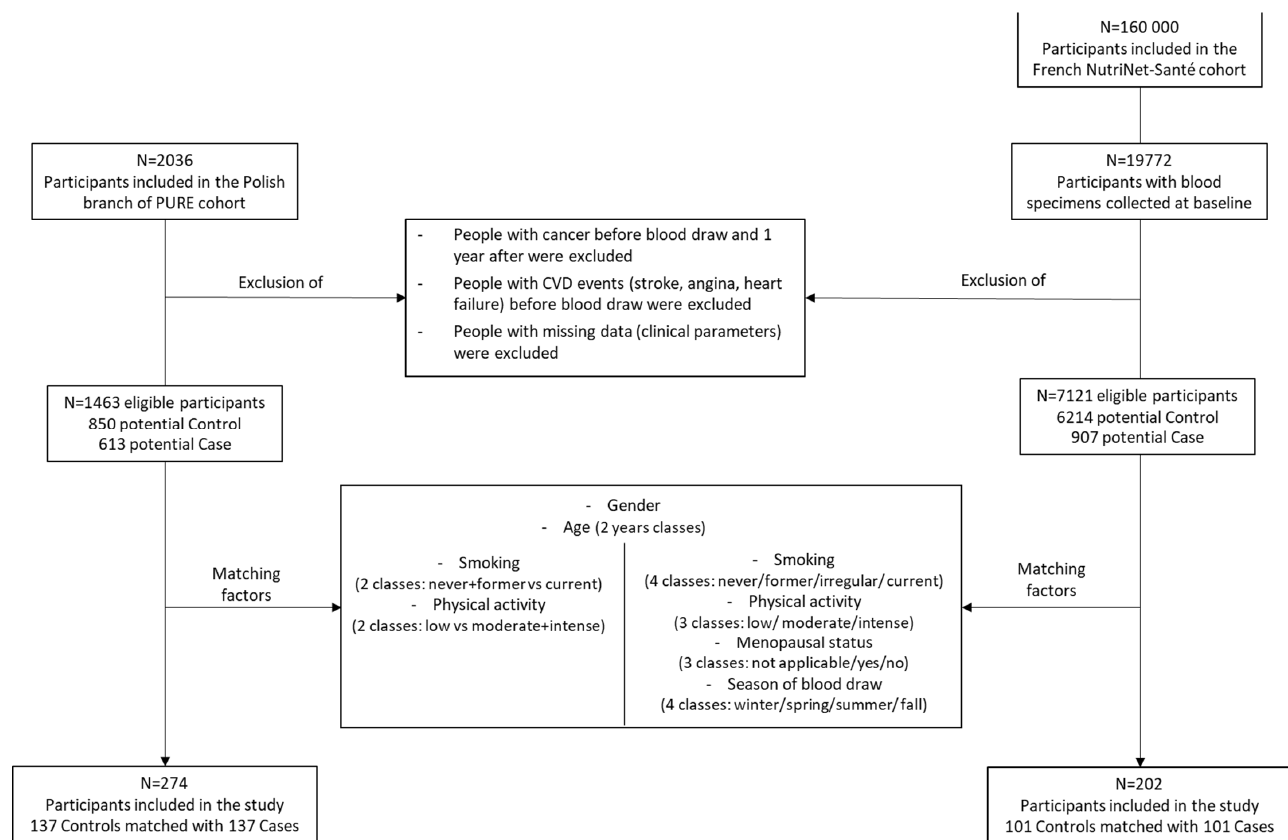
Figure 7. Participant’s selection for the Discovery and Replication studies. Control group: participants with <3 MetS criteria and Case group: participants with ≥ 3 MetS criteria (waist circumference, high blood pressure, hypertriglyceridemia, low HDL-c and hyperglycemia). To avoid the selection of incomparable Control participants between the two cohorts, the Control groups of each study were balanced according to the number of MetS criteria (i.e., 0, 1 or 2).